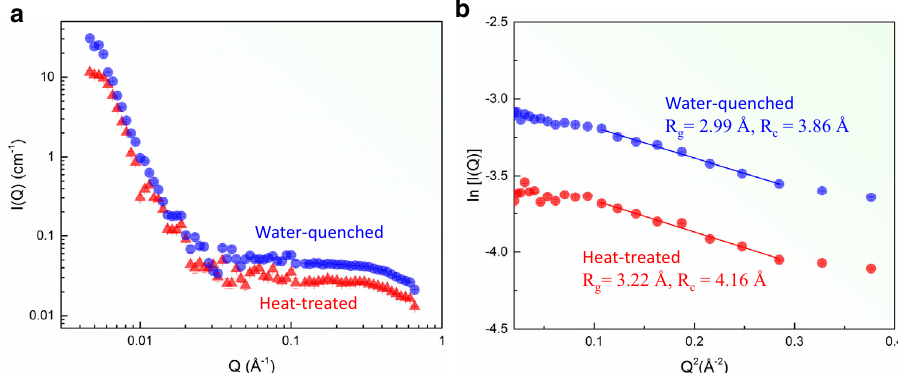
Fig. 5 | Local chemical clustering detected by small-angle neutron scattering (SANS).a SANS-intensitydistributionasafunctionofmomentumtransfer,Q,ofthe